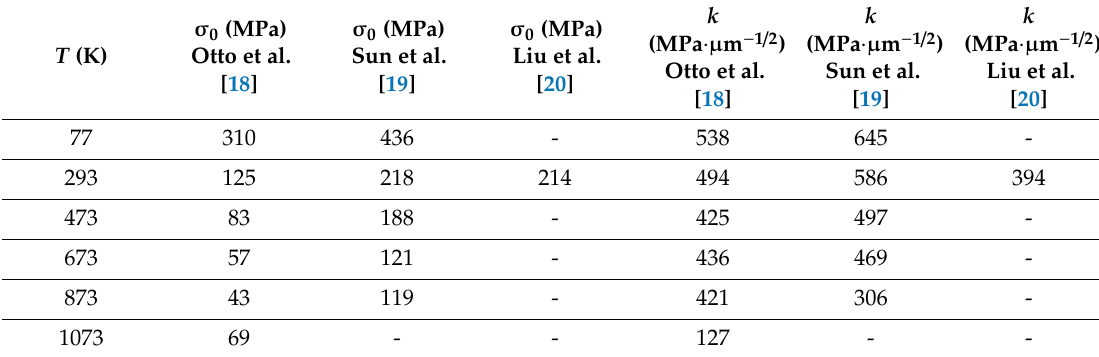
Table 1. Values of the Hall–Petch parameters at di ff erent temperatures for CoCrFeMnNi. From Otto et al. [18], Sun et al. [19], and Liu et al.